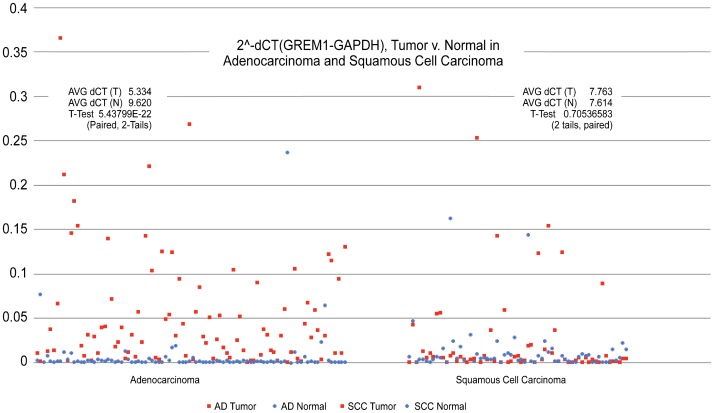
Gremlin is significantly overexpressed in lung AD but not lung SCC.A Taqman qRT-PCR was performed using GREM1 probe and a GAPDH control. Data are represented as GREM1 expression normalized to GAPDH expression for each sample. Gremlin expression was higher in AD specimens than matched normals (N = 96, p = 5.438×10−22). There was no significant change in expression in the SCC samples (N = 65, p = 0.705).